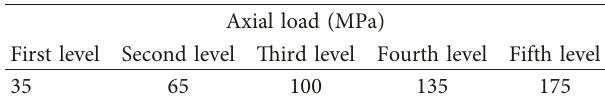
Figure 3: Temperature-stress coupling triaxial rheometer equip- ment (after Zhang et al. [29]). Table 1: Sandstone rheological test load level.